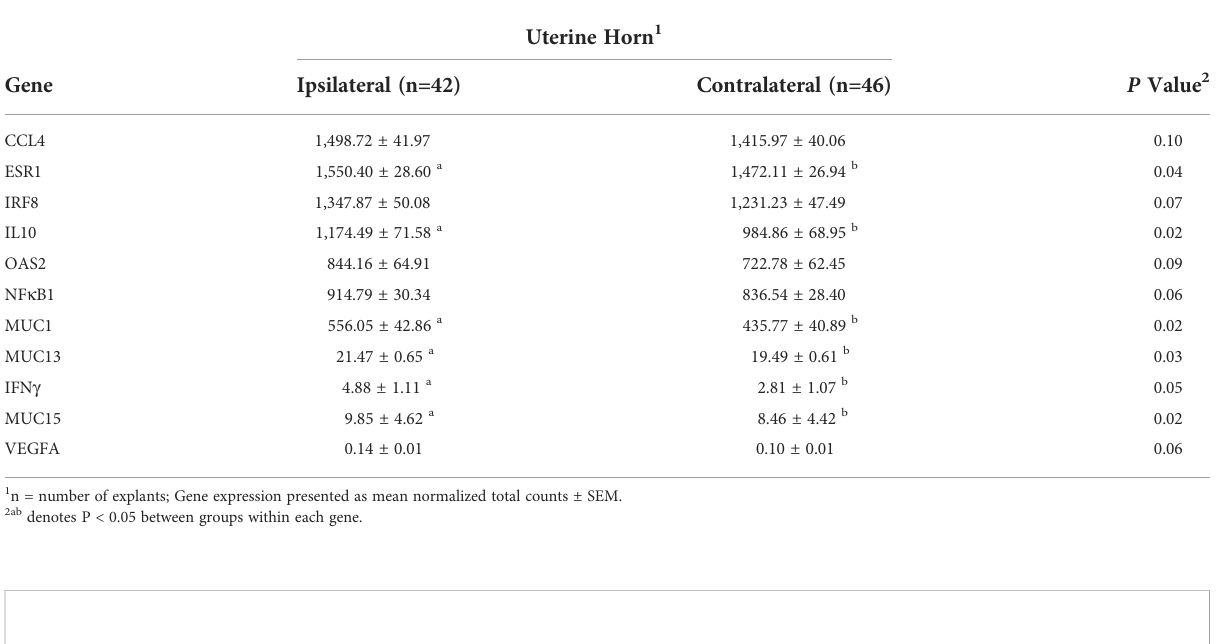
TABLE 4 Expression of genes affected by uterine horn.